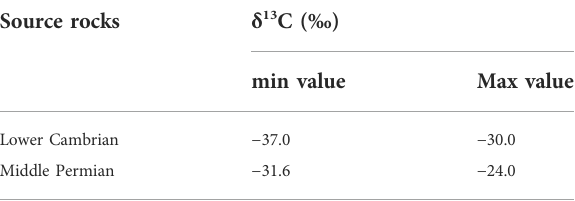
TABLE 2 Carbon isotopic data of the Lower Cambrian source rocks and Middle Permian source